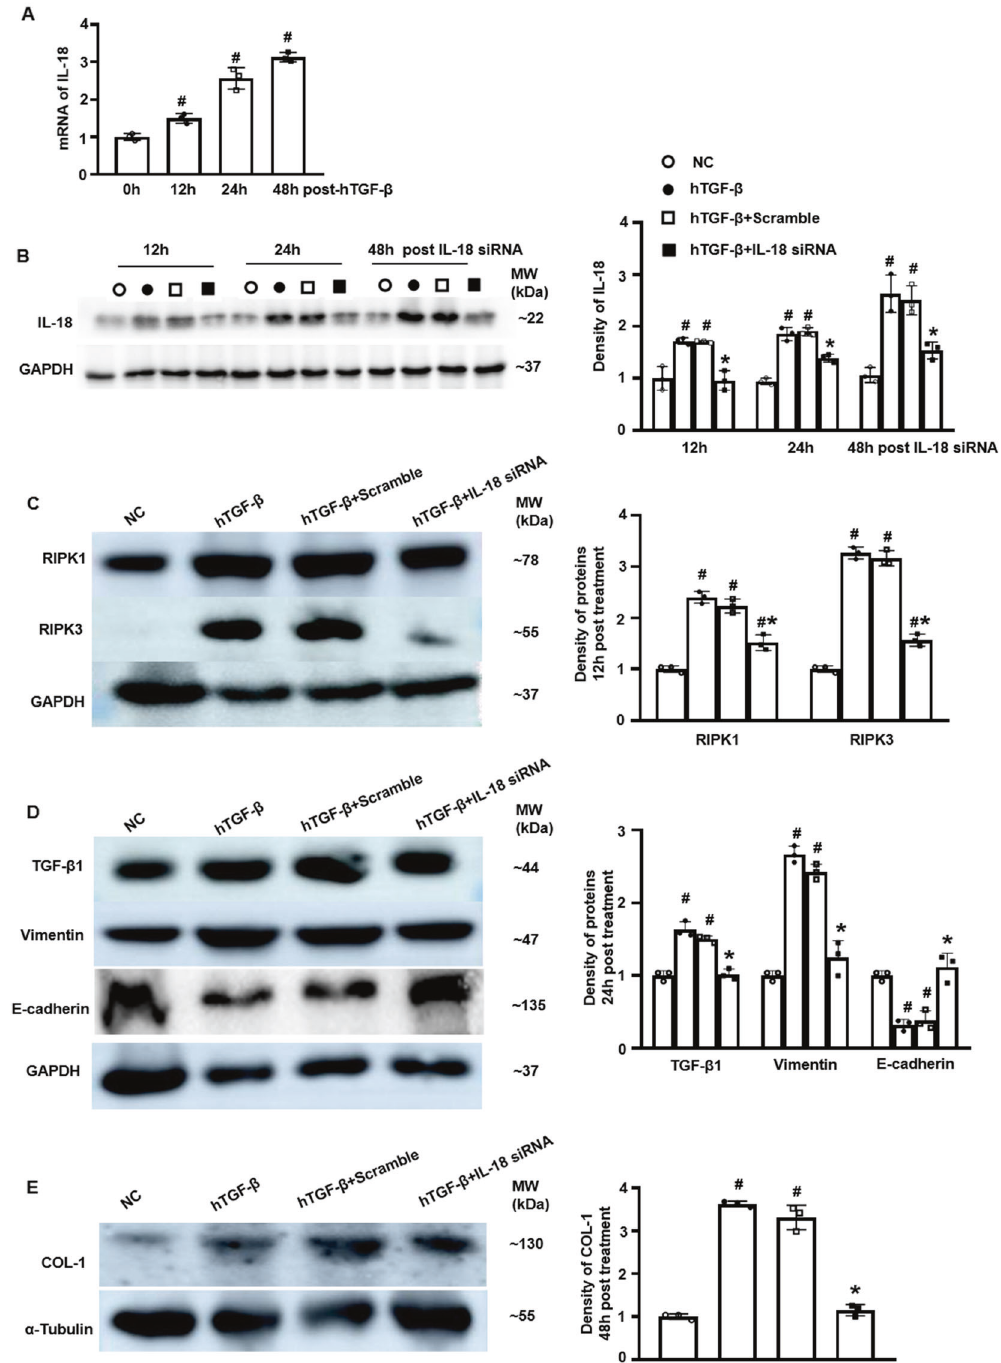
Fig. 7 IL-18 knockdown attenuated necroptosis, transdifferentiation, and fi brosis in HK-2 cells. A The mRNA expression of IL-18 in HK-2 cells with hTGF- β stimulation by qPCR. B The protein expression of IL-18 HK-2 cells treated with hTGF- β and additional transfected with IL-18 siRNA and its scramble analyzed by Western blotting. C The protein expression of necroptosis indicated by RIPK1 and RIPK3 at 12 h after the transfection of IL-18 siRNA on Western blotting. D The expression of transdifferentiation marked by TGF- β 1, vimentin, and E-cadherin at 24 h after the transfection of IL-18 siRNA on Western blotting. E The expression of fi brotic COL-1 at 48 h after the transfection of IL-18 siRNA on Western blotting ( n = 3, # p < 0.05, other groups vs. NC; * p < 0.05, IL-18 siRNA vs. IL-18 scramble). Tubulointerstitial fi brosis is a common feature of progressive These factors were considered as the main phase of transdiffer- CKD [49]. Inhibition of IL-18 reduces renal fi brosis after ischemia/ entiation. IL-18 de fi ciency reversed the changes of thses transdif- reperfusion [13]. We also found that the expression of COL-1, a ferentiation proteins at day 14 after FA-induced AKI (Fig. 3). These renal fi brosis biomarker, increased gradually and peaked at day 30 results suggested that transdifferentiation may trigger later fi brosis after FA injection. Overexpression of COL-1 was suppressed by IL- formation of AKI and that IL-18 deletion might reduce transdiffer- 18 deletion (Fig. 4). This suggested that IL-18 de fi ciency entiation, to further slowdown progression from AKI to CKD. Cell Death and Disease (2022)